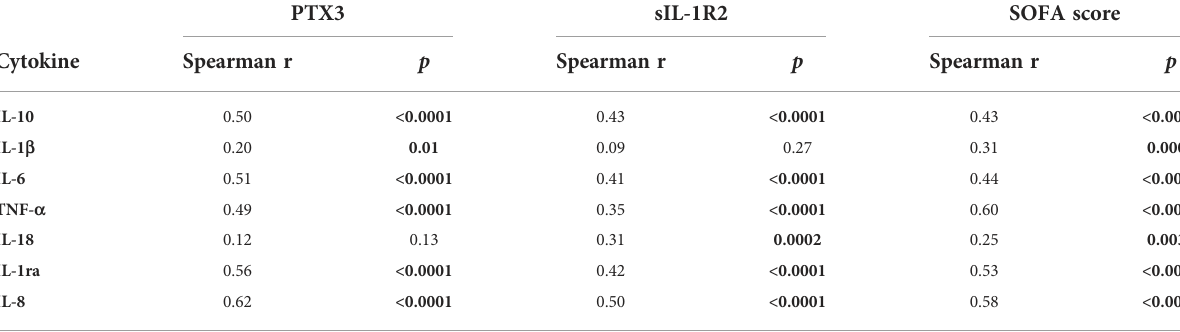
TABLE 4 Univariable correlations of PTX3, sIL-1R2 and SOFA score with cytokines in the Sepsis-3 population (n=135). PTX3 sIL-1R2 SOFA score